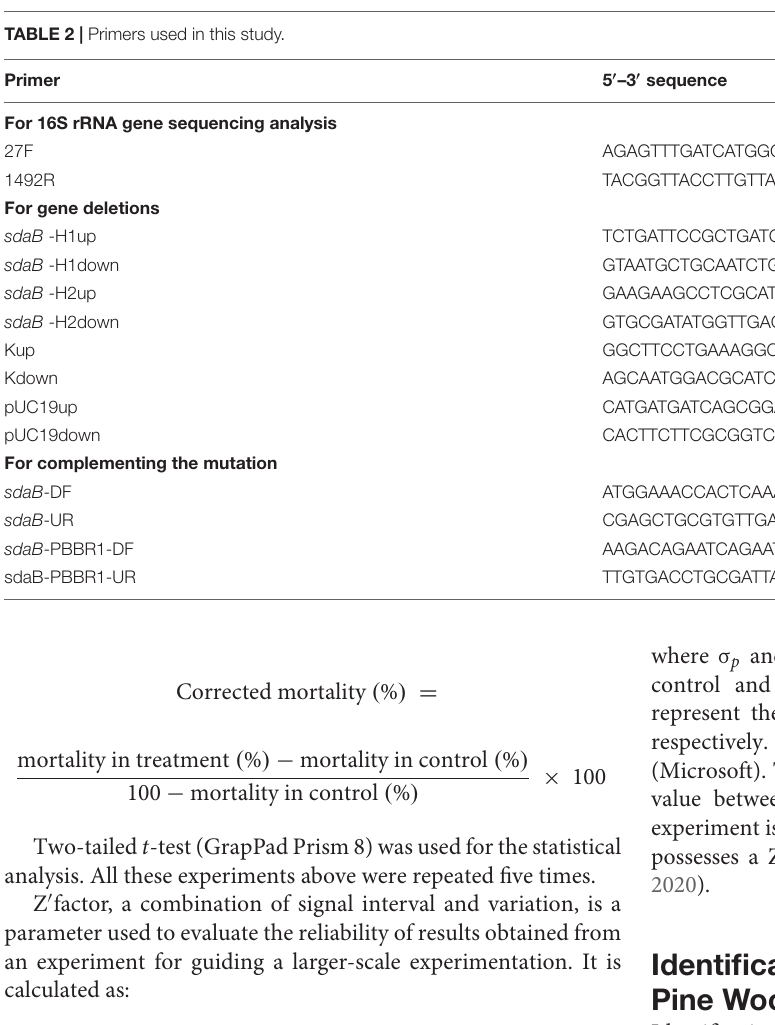
TABLE 2 | Primers used in this